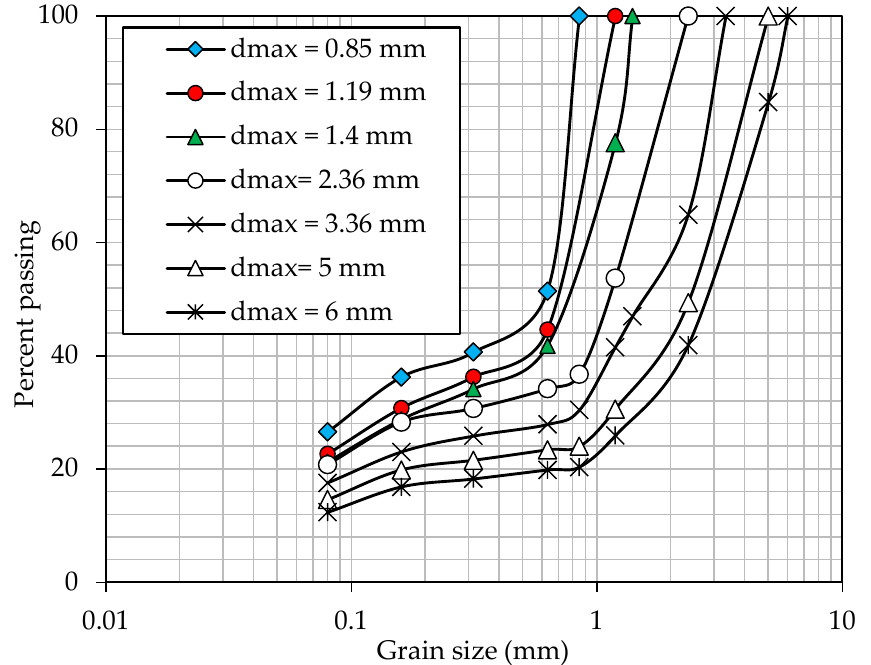
Figure 4. Grain size distribution curves of the samples with different d max (same for WR 1 and WR 2).